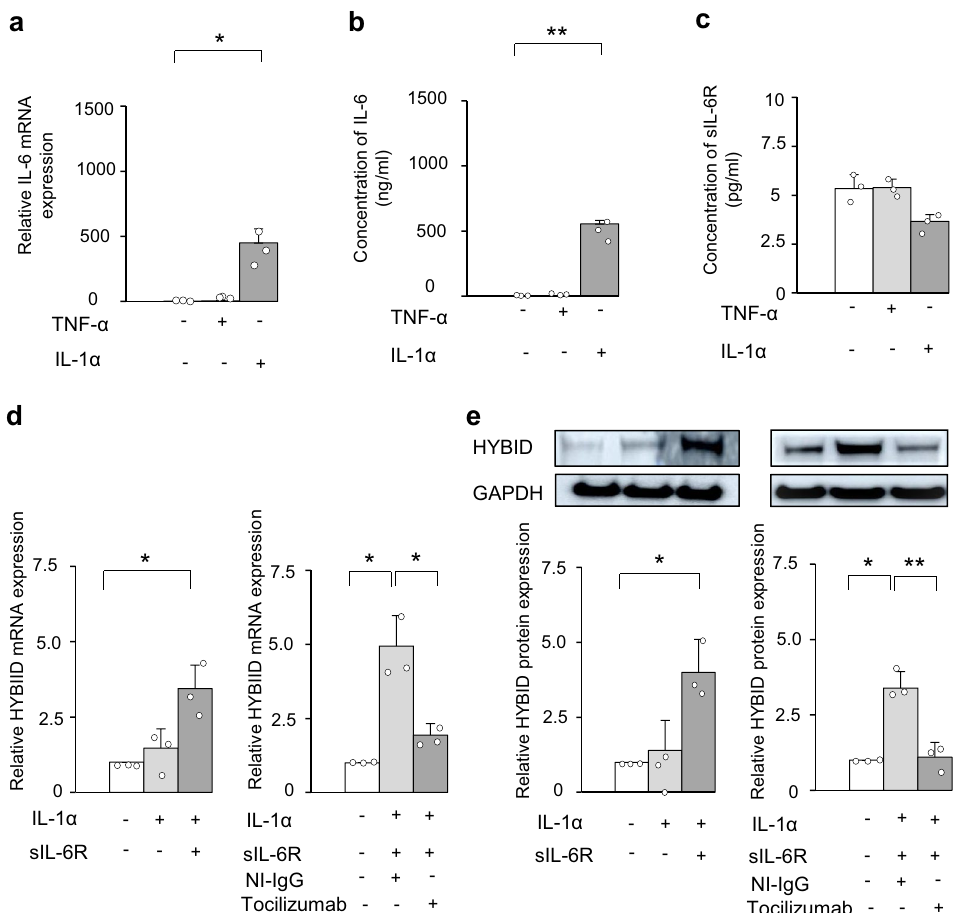
Figure 5. Expression of IL-6 and sIL-6R in OA chondrocytes treated with TNF-α or IL-1α and involvement of IL-6 in IL-1α-stimulated HYBID overexpression. ( a ) and ( b ) Overexpression of IL-6 in OA chondrocytes treated with IL-1α. OA chondrocytes at P2 were treated with TNF-α (0 or 10 ng/ml) or IL-1α (0 or 10 ng/ml) for 24 h, and mRNA isolated from cell lysates was subjected to quantitative real-time PCR for IL-6 using the ΔΔCt method ( a ). Concentrations of IL-6 produced into culture media by OA chondrocytes treated with TNF-α (0 or 10 ng/ml) or IL-1α (0 or 10 ng/ml) for 48 h were measured by ELISA ( b ). The average HYBID:GAPDH ratio in control OA chondrocytes treated with vehicle was set at 1. ( c ) Concentration of sIL-6R in culture media of OA chondrocytes treated with IL-1α or TNF-α. OA chondrocytes were treated with IL-1α (0 or 10 ng/ml) or TNF-α (0 or 10 ng/ml) for 24 h and culture media were subjected to ELISA for sIL-6R. ( d ) and ( e ) IL-6- mediated HYBID overexpression in OA chondrocytes stimulated with IL-1α. OA chondrocytes were treated with IL-1α (0 or 10 ng/ml) in the presence or absence of sIL-6R (100 ng/ml) for 24 h and 48 h, and the mRNA and protein expression of HYBID was analyzed by quantitative real-time PCR using the ΔΔCt method ( d ) and immunoblotting with anti-HYBID antibody ( e ). To examine the involvement of IL-6 in IL-1α-stimulated HYBID expression, the expression was analyzed by treating the IL-1α (10 ng/ml) and sIL-6R (100 ng/ml)- stimulated chondrocytes with non-immune IgG (NI-IgG, 25 µg/ml) or anti-IL-6R antibody (tocilizumab, 25 µg/ ml). Values are expressed mean ± SD (n = 3). *, P < 0.05; **, P < 0.01. The uncropped full-length gels are presented in Supplementary Figure